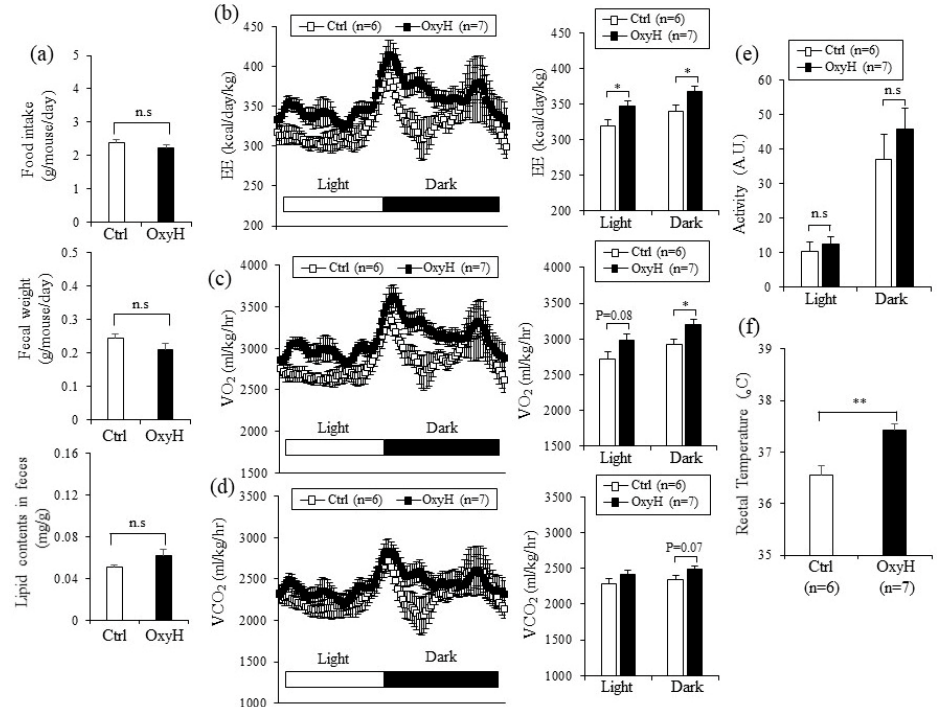
Figure 2. Oxyresveratrol increases energy expenditure in HFD-fed obese mice. ( a ) Male C57BL/6N mice were fed a HFD and treated with vehicle control (Ctrl) or oxyresveratrol (OxyH, 15 mg/kg per day) for 8 weeks. Food intake (top), fecal weight (middle), and lipid contents in feces (bottom) of vehicle control (Ctrl) or oxyresveratrol (OxyH)-treated obese mice. ( b ) Energy expenditure, ( c ) oxygen consumption, and ( d ) carbon dioxide production were measured in control (Ctrl, n = 6) or oxyresveratrol (OxyH, n = 7) treated mice by indirect calorimetry using Oxylet system after 3 weeks on HFD. Energy expenditure was measured before body weights started to diverge. Bar graph (right panel) represents the average energy expenditure, O 2 consumption, and CO 2 production in each group. ( e ) Total physical activities of control ( n = 6) and oxyresveratrol-treated mice ( n = 7). ( f ) Rectal temperature was measured in mice treated with control ( n = 6) or oxyresveratrol ( n = 7). Data represent mean ± s.e.m. and statistically significant differences between control or oxyresveratrol-treated mice were determined using Student’s t -test (* p < 0.05; ** p < 0.005).